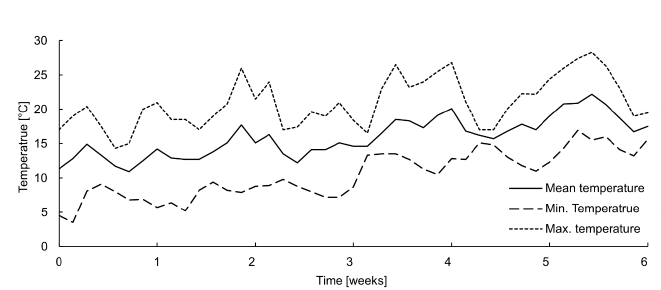
Fig. 1: Minimum, maximum and mean temperature measured at the Trollenhagen weather station (University of Applied Sciences Neubrandenburg) during the